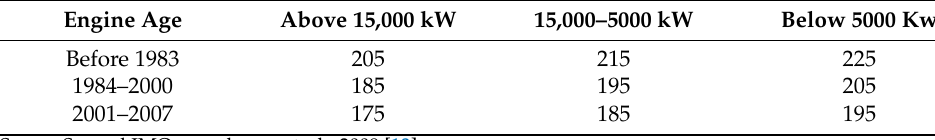
Figure 4. Procedure of the bottom-up approach using AIS data. Table 4. SFOC (g/kW h) of main engines.